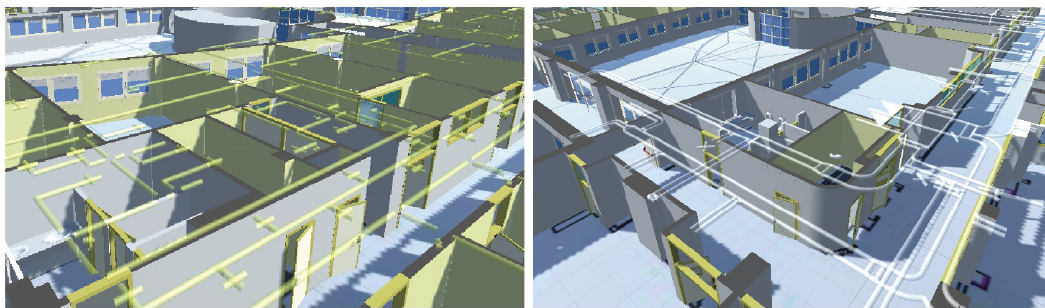
Figure 3. Virtual representation of indoor infrastructures and structural elements of the study area.